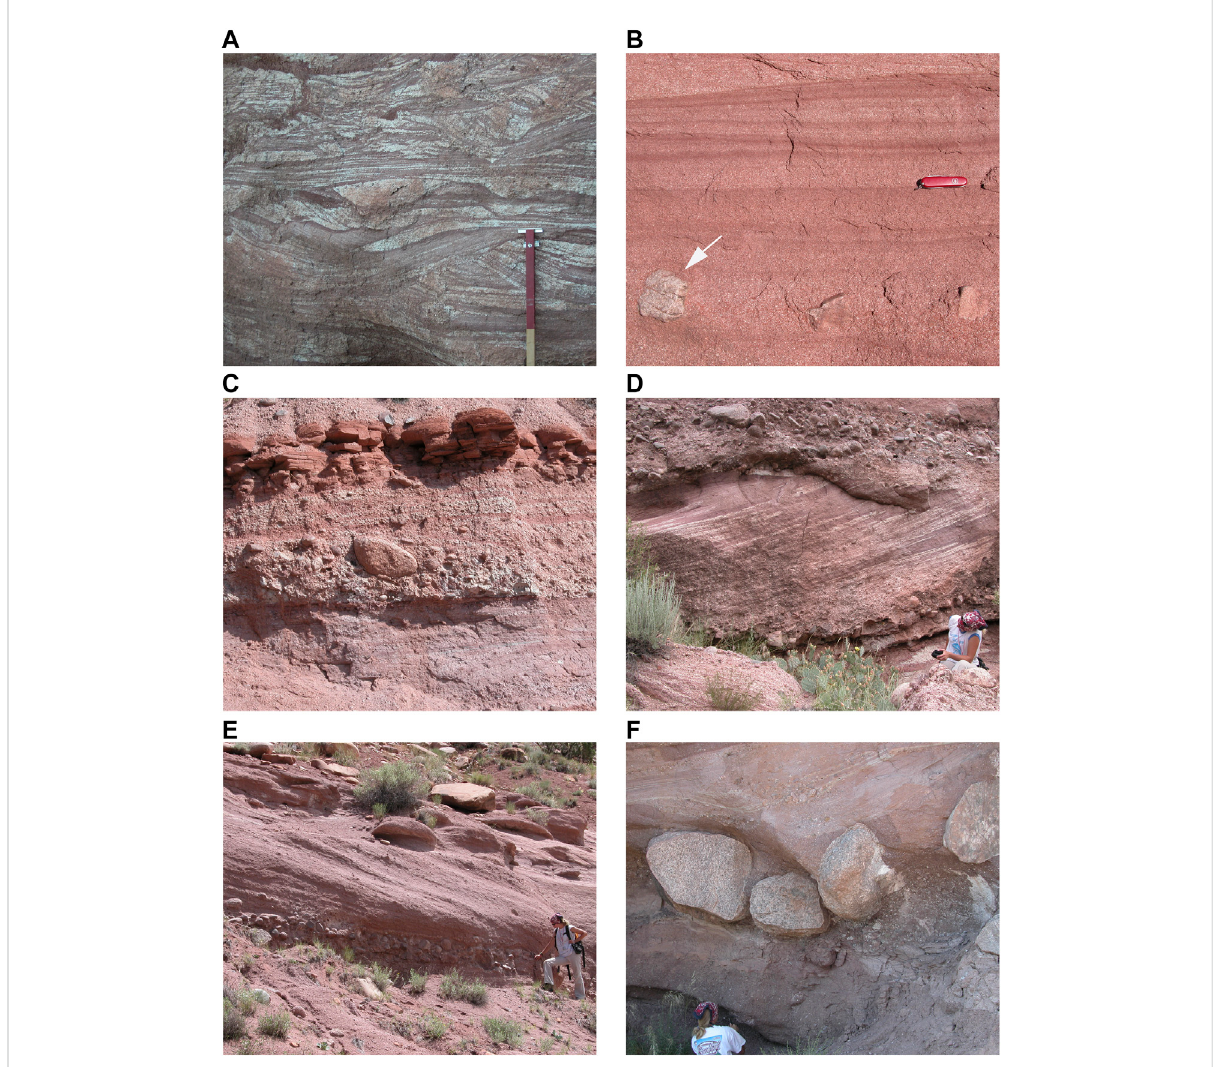
FIGURE 3 PhotographsdepictingawidevarietyoffaciesobservedintheCutlersystemcommontoproglacial fl uvialsystems. (A) Scour-and- fi lldeposition of coarse-to granule-sized sandstone. Red component of Jacob Staff is 50 cm. (B) Low-concentration HFF deposit demonstrating horizontal and low-angle strati fi ed sand and fl oating clasts. Floating clast indicated by white arrow is approximately 10-cm diameter. (C) High-concentration HFF demonstrating pulses of grading and outsized fl oating clasts (overlain by silt layer). (D,E) Large-scale cross bedding with foreset heights up to 2.5 m.Thisbedistraceableforatleast750 malongstrikeoftheforesetdip. (F) Meter-scalebouldersinadebris fl owofthe fl uvialsystem. (G) Deposit demonstrating a hydrograph pulse where low-angle planar cross-strati fi cation composes the base of the deposit, but transitions upward into high- concentration HFF deposit denoted by reverse grading and outsized clasts. Top of the bed exhibits normal grading and is capped by siltstone that drapes the unit. White arrow points to a ~15-cm diameter clast. (H,I) Deposits containing rip-up clasts of noncohesive fi ne sandstone and siltstone (white arrows). Inverse to normal grading apparent in (I) . (J,K) Pebbly mudstone deposits interpreted as cohesive fi ne-grained debris fl ows that underwent in fl ation during fl ow to reduce competency. See text for details. White arrow denotes a sandstone dike within the pebbly mudstone bed. (L) HFF with fl oating cobble in silt-sand matrix (snake for